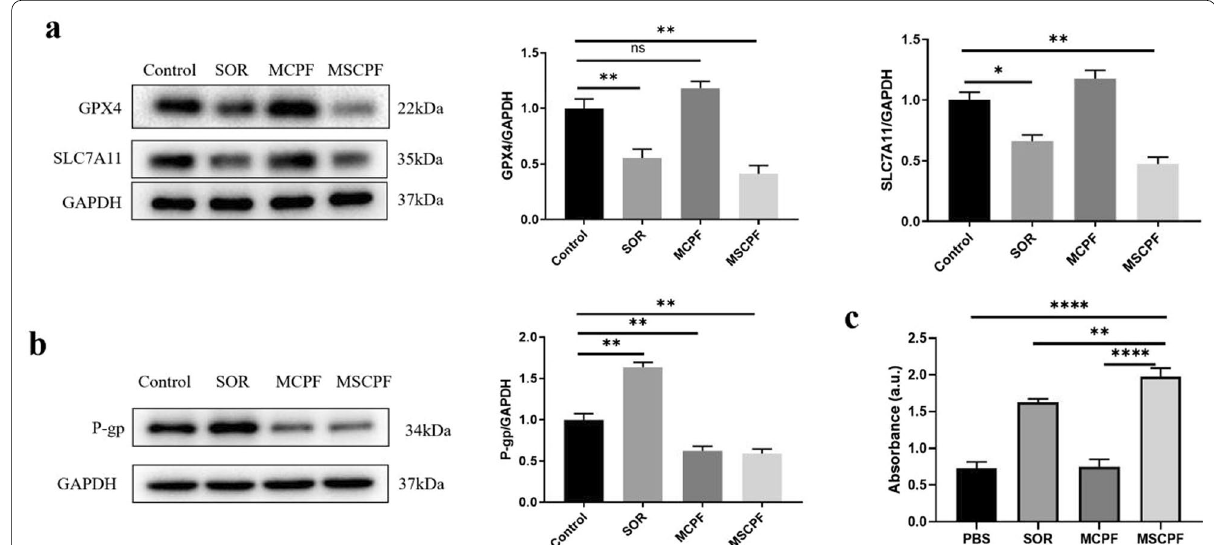
Fig. 6 a WB assay and quantitative analysis of the expression of GPX4 and SLC7A11 in vitro studies. b WB assay and quantitative analysis of the expression of P-gp in SMMC-7721 cells treated by PBS, SOR, MCPF, or MSCPF (660 nm irradiation at 500 mW cm − 2 and 808 nm irradiation at 1.5 W cm − 2 ). c Concentration assay of sorafenib in cells after SOR, MCPF and MSCPF treatment using Uv-vis